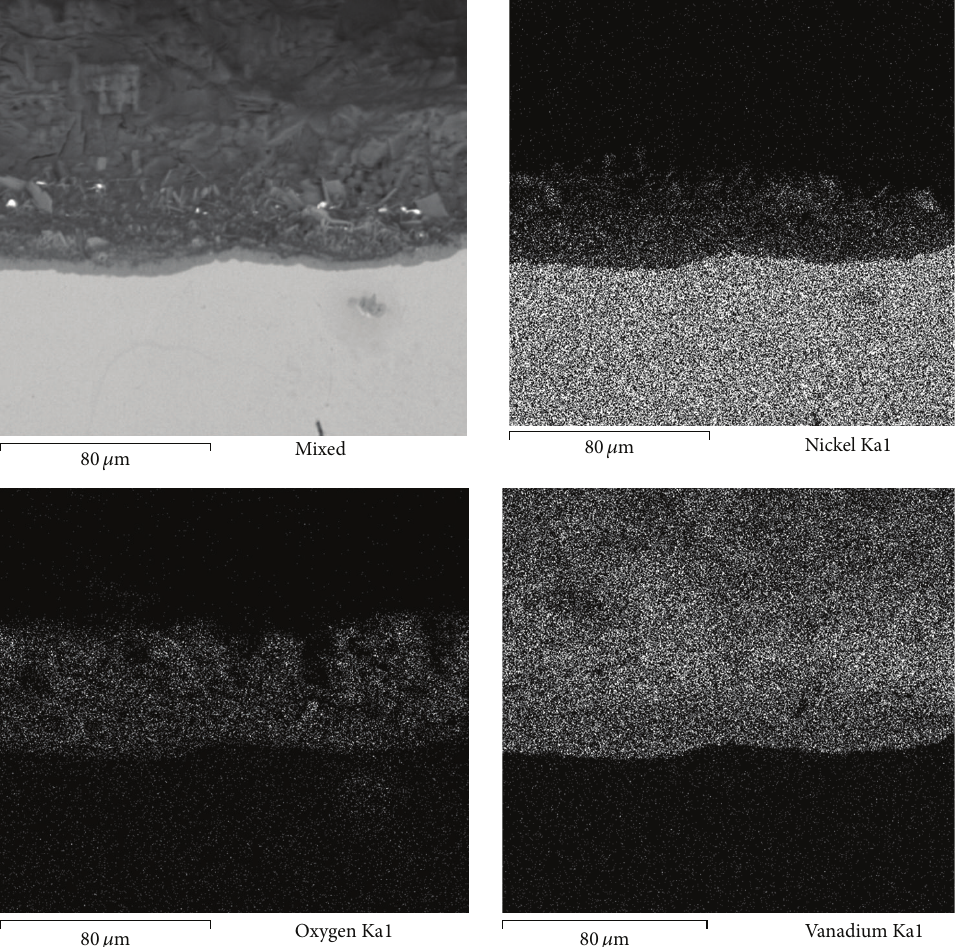
Figure 4: Electron image of the metal-scale interface and X-ray mappings of Ni, O, and V when pure metal nickel was exposed to NaVO 3 at 700 ∘ C during 100 hours.